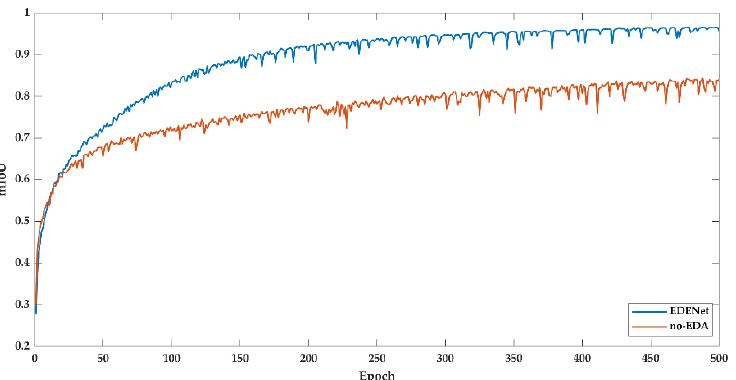
Figure A1. Training loss of Vaihingen dataset.